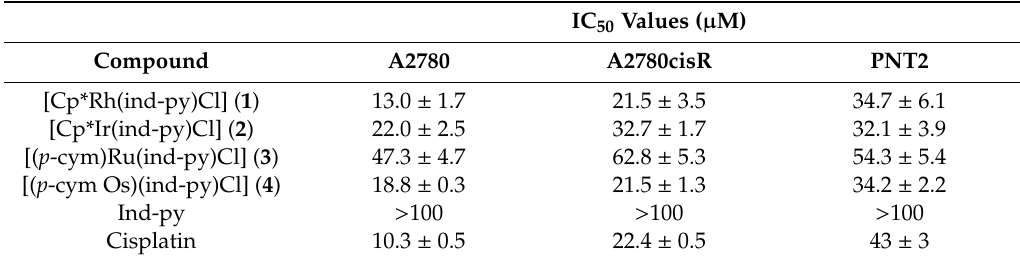
Table 2. IC 50 values (µM) in A2780, A2780 cisplatin resistant and PNT2 cells for complexes 1 – 4 .